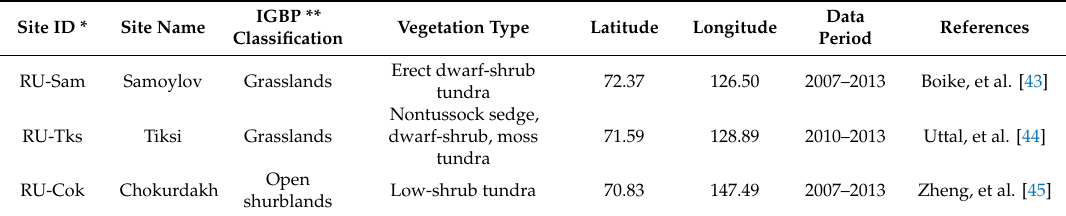
Table 2. List of eddy-covariance tower information for the